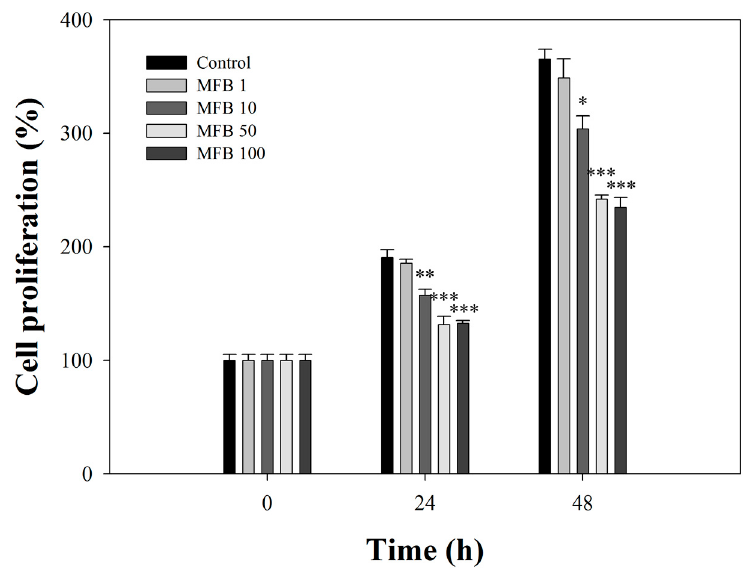
Figure 2. Effects of MFB on cell proliferation of SK-Hep-1 cells. Cells (1 × 10 4 ) were incubated with MFB (1–100 µg/mL) for 24 and 48 h. MFB1, MFB10, MFB50, and MFB100 represent 1, 10, 50, and 100 µg/mL, respectively. Values (means ± SD, n = 3) at the same time point significant difference from control value was indicated * p < 0.05, ** p < 0.01, and *** p < 0.001.